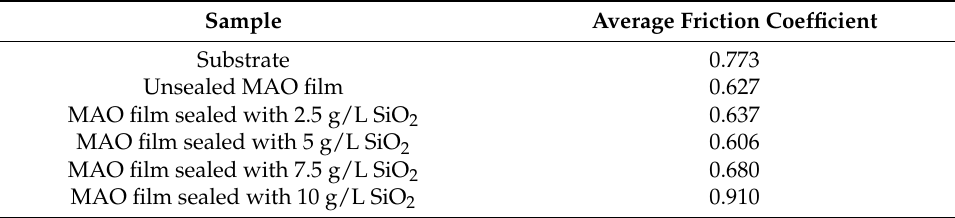
Figure 6. Wear track images of unsealed MAO film and MAO films sealed by SiO 2 nanoparticles. Table 4. Average friction coefficient of different specimens.